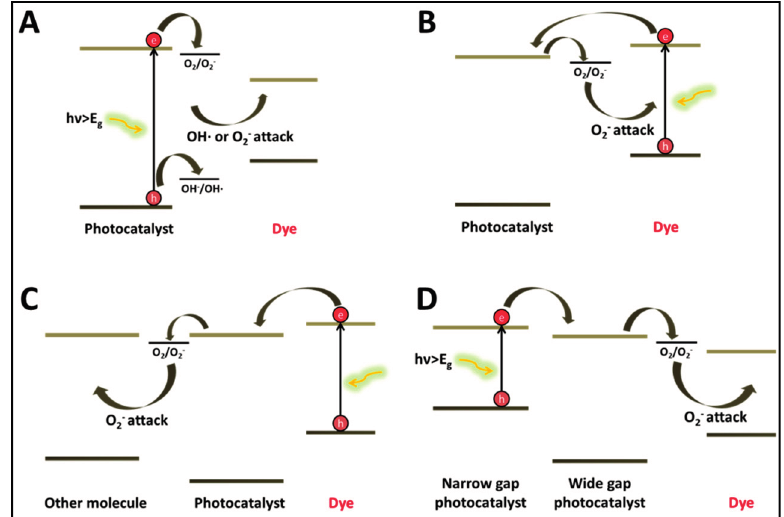
Figure 1. The mechanisms of light-induced degradation of dyes ( A ) photocatalysis ( B ) dye sensitization followed by dye degradation ( C ) dye sensitization followed by reduction of a second molecule; ( D ) degradation by coupled semiconductors under visible